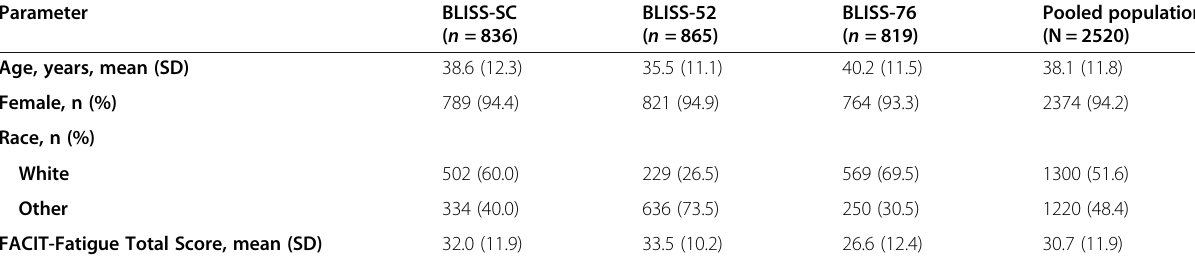
Table 1 Demographics and baseline characteristics of participants in the three SLE trials Parameter